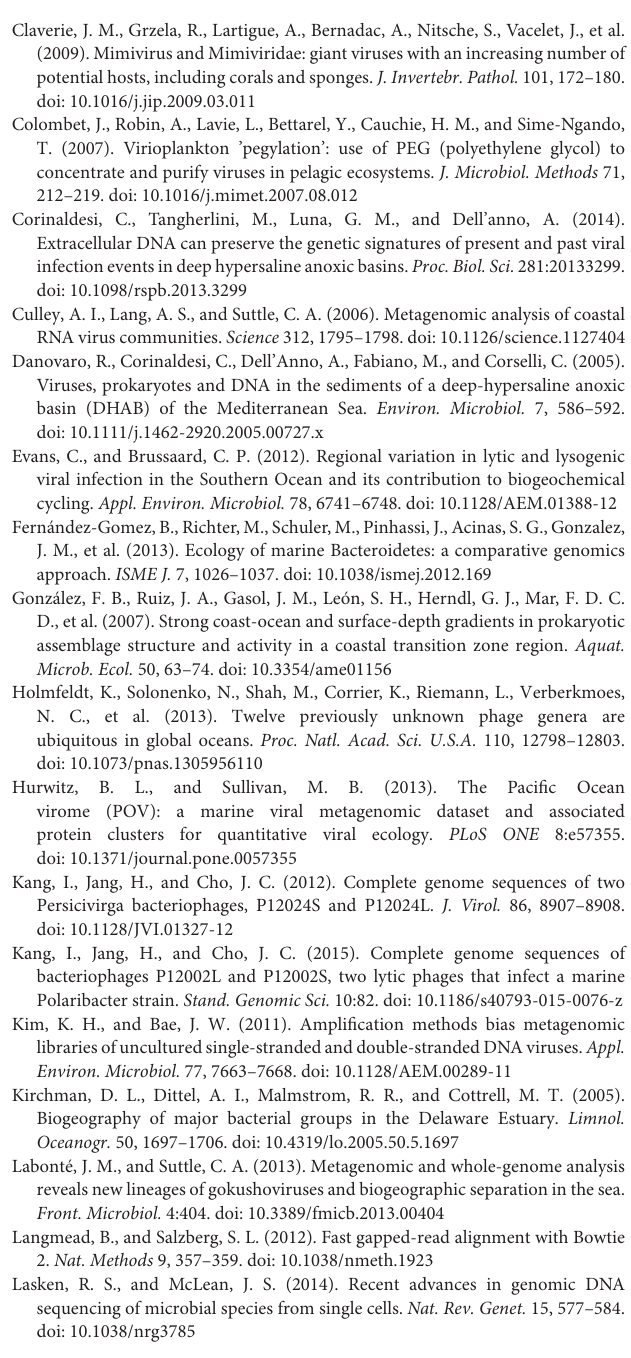
Figure S3 | Affiliated and unaffiliated contigs in Prydz Bay. Affiliated contigs: contigs were assigned to be of viral origin; affiliated dsDNA viruses contigs: contigs were assigned to be of dsDNA viruses. Figure S4 | Relative abundances of viral contigs after normalization (DNA-RPKM). Figure S5 | Redundancy analysis of the relationship between the relative viral abundance of viral species and environmental factors. DO, dissolved oxygen; Chl a , chlorophyll a ; NO 3 -N, nitrate; NH 4 -N, ammonium.